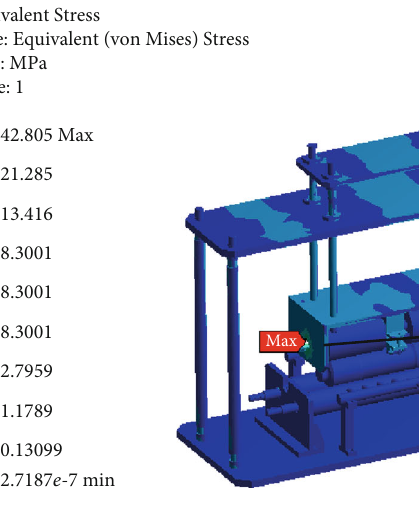
Figure 13: Result of structural analysis of the equipment.